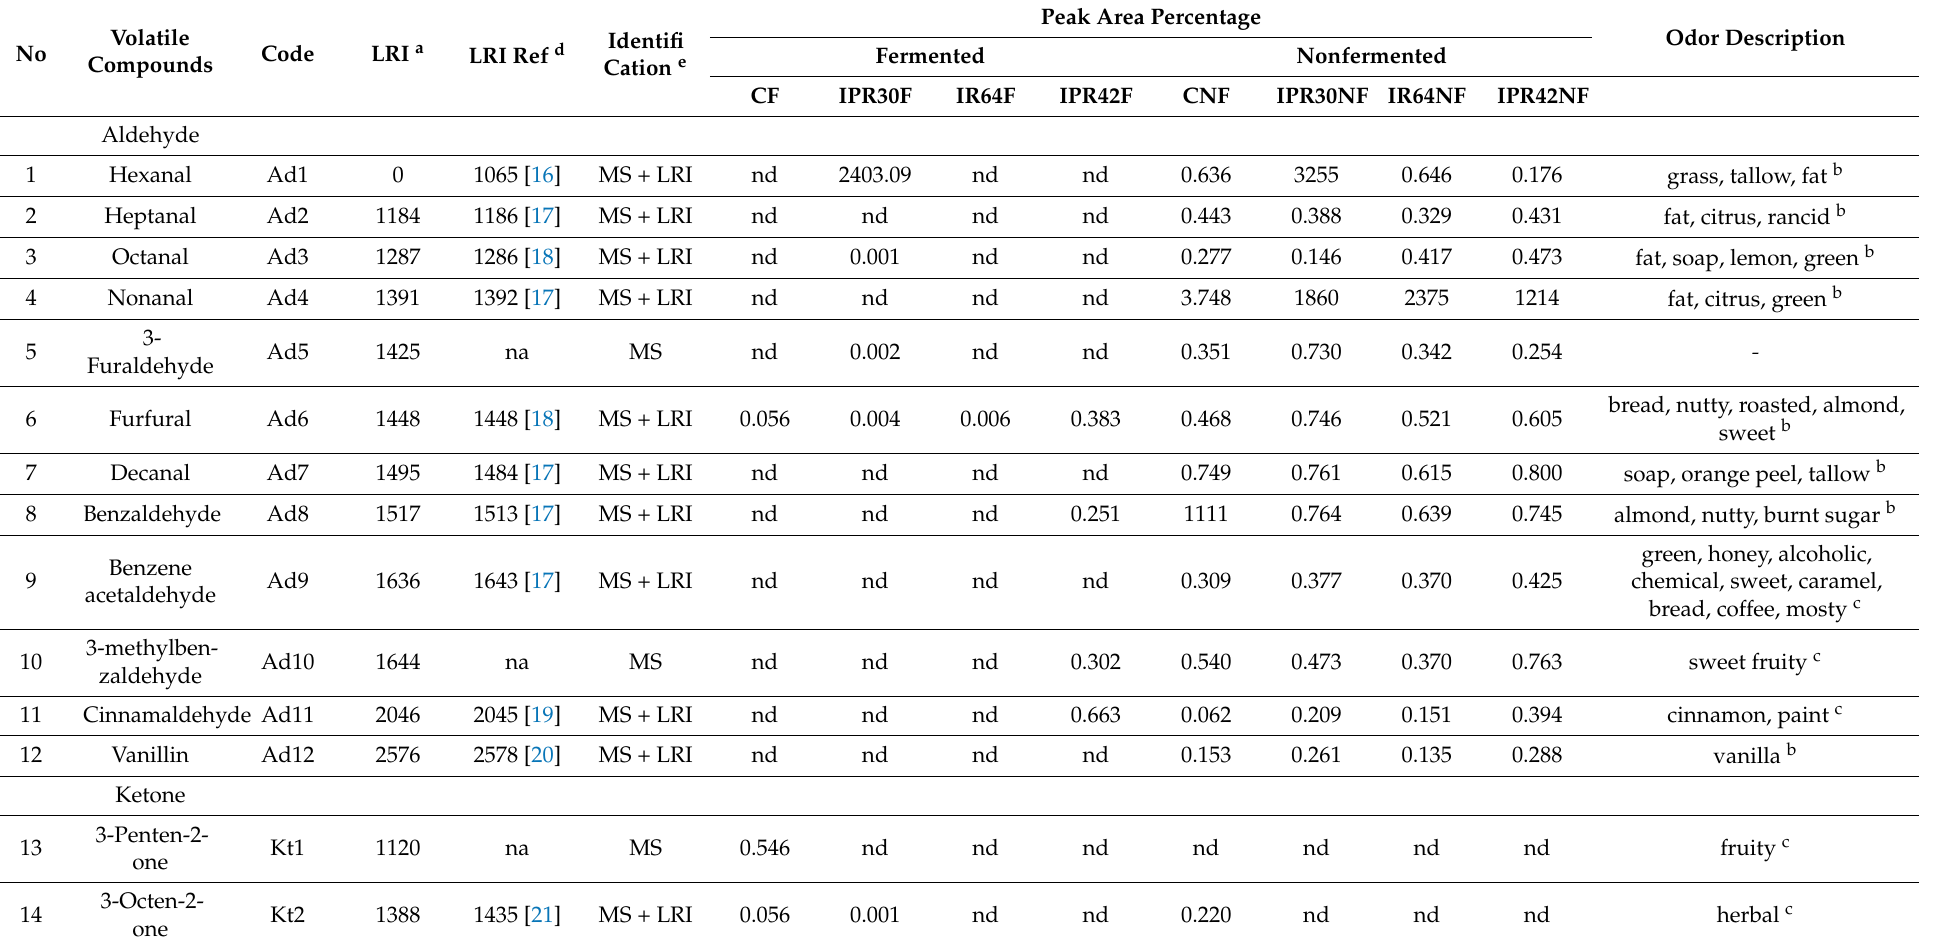
Table 1. Volatile compounds of fermented and nonfermented rice